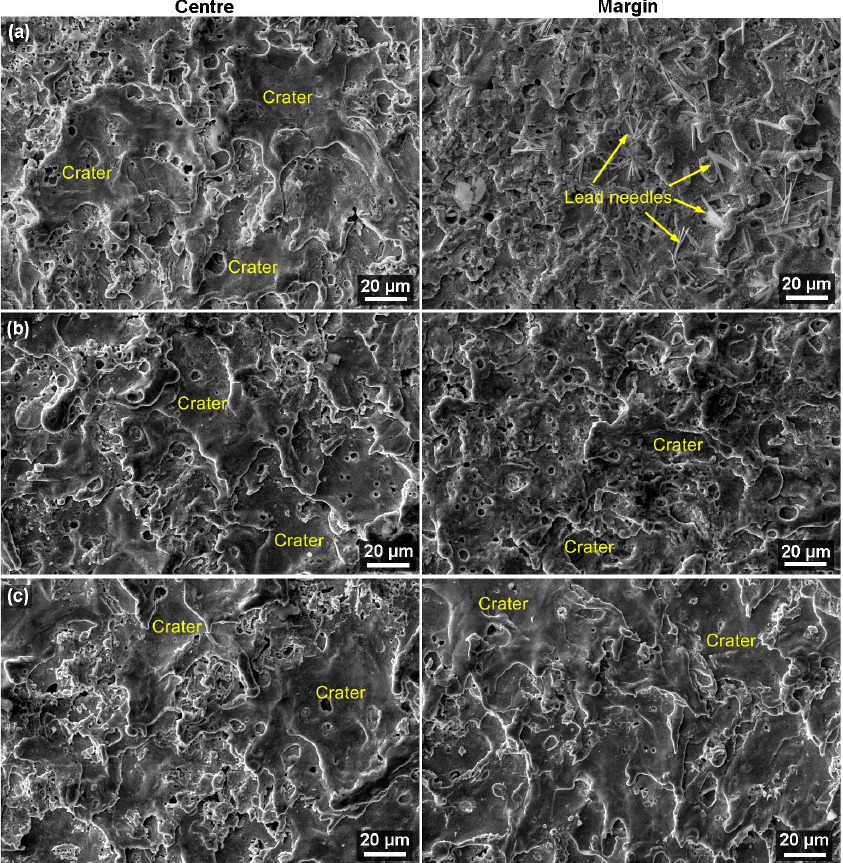
Figure 7. Surface morphology of samples at the margins and in the center of SEM/SE, ( a ) sample with a thickness of 100 mm, ( b ) sample with a thickness of 135 mm, ( c ) sample with a thickness of 160 mm.